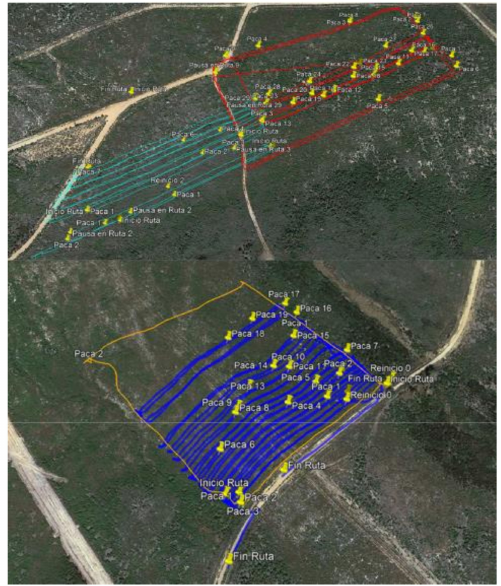
Figure 1. Biobaler strips and georeferenced bales in Site 1 (above) and Site 2 (below) strata. The main parameters of the study sites are reflected in Table 1. Table 1. Stand average parameters of study sites 1 (Tabuyo) and 2 (Castrocontrigo). Acronyms: S, surface; h, height;